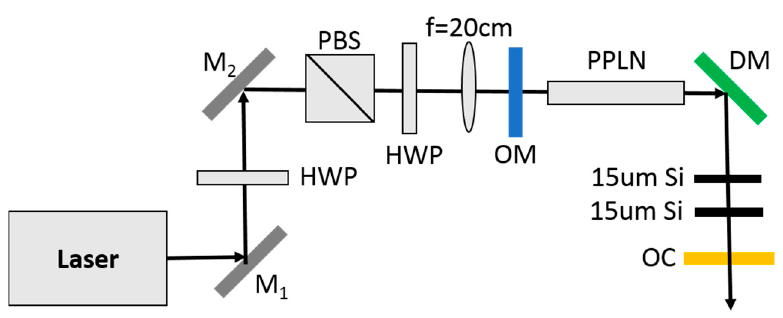
Figure 5. Schematic diagram of OPO system.